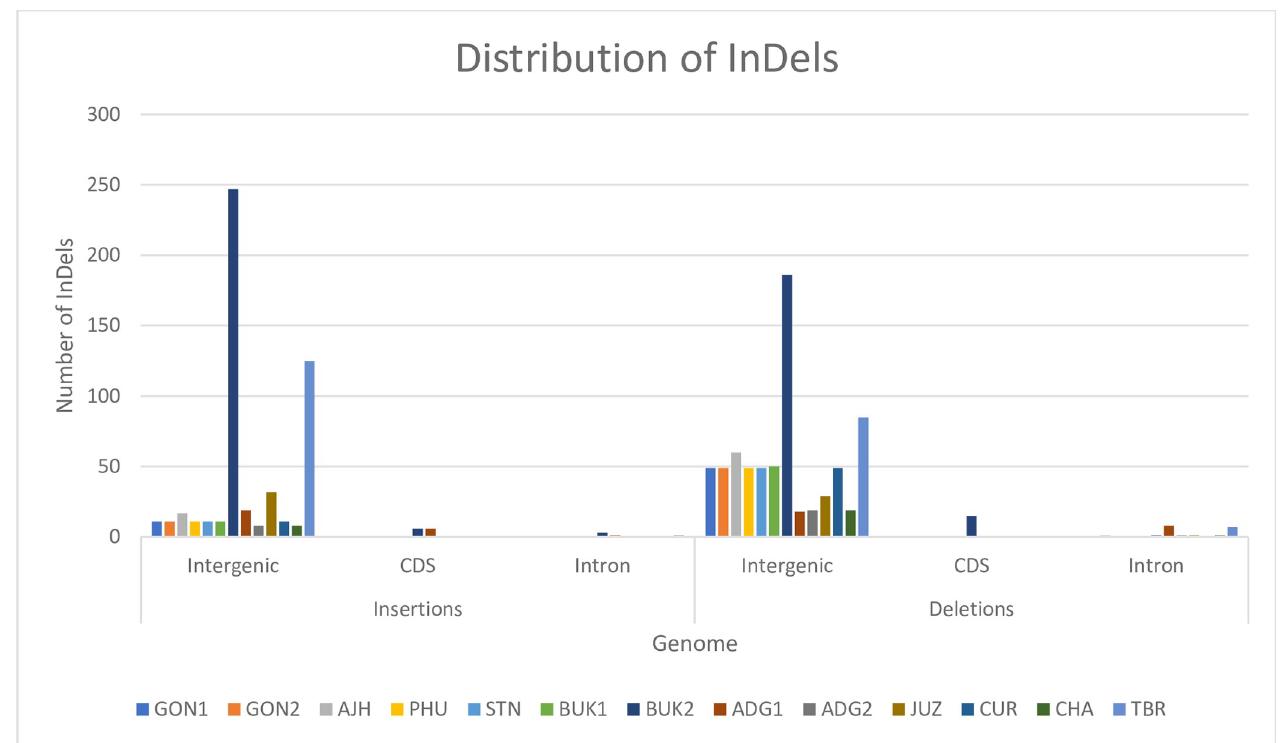
Fig 4. Distribution of InDels in a panel of 13 potato plastomes. Comparatively, BUK2 and TBR have the greatest number of InDels of all the plastomes. More than 90% of the InDels are present in intergenic regions.